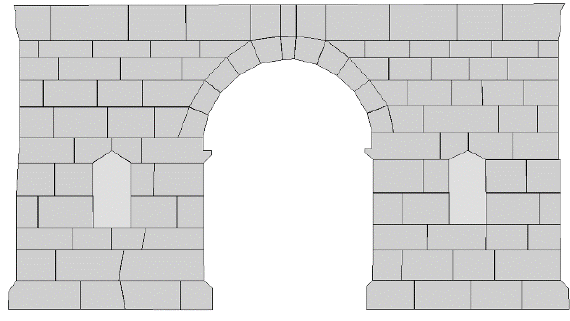
Figure 12. Mechanical model of the arch in its current configuration.